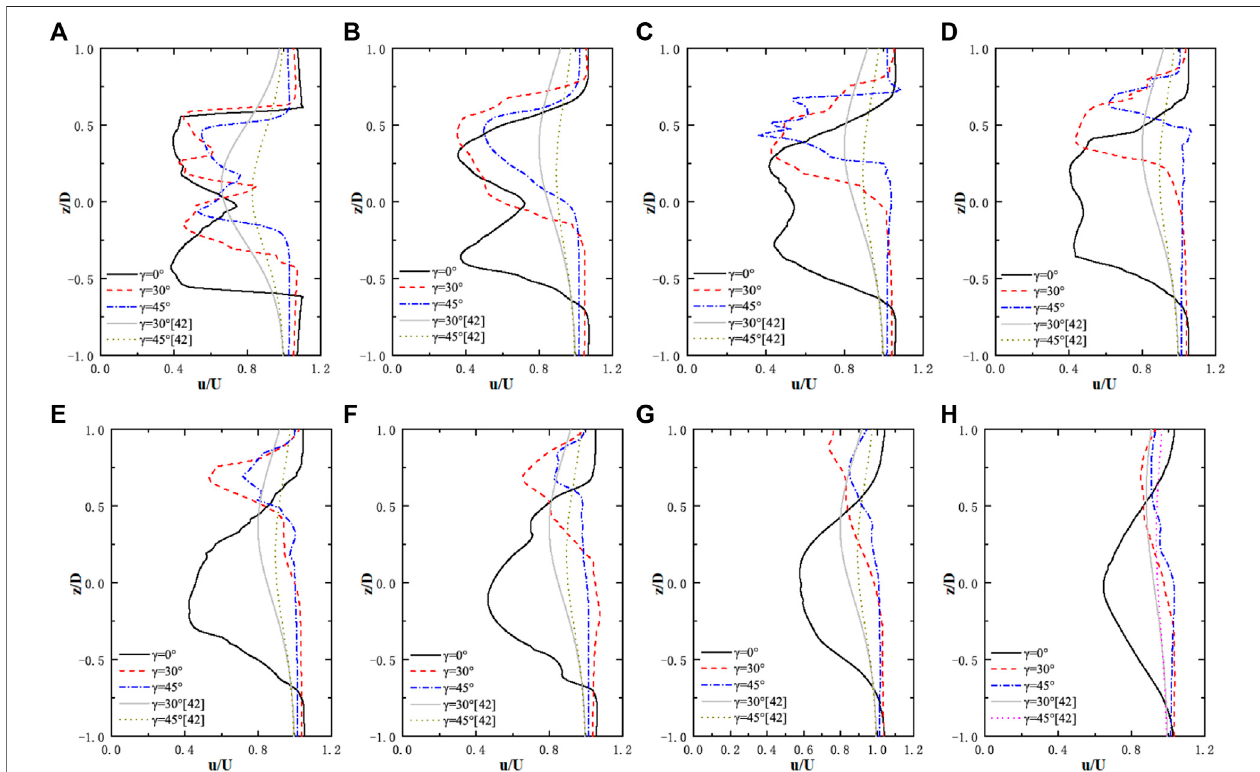
FIGURE14| CalculationresultsofwakevelocityinyawatdifferentaxialdistancesofthehubheightcomparedwiththepredictionresultsofBastankhah ’ sanalytical model (Bastankhahand Porté-Agel, 2016).[The gray solid line and the dotted lineare the prediction results ofthe yaw wake model (Bastankhah and Porté-Agel, 2016)]: